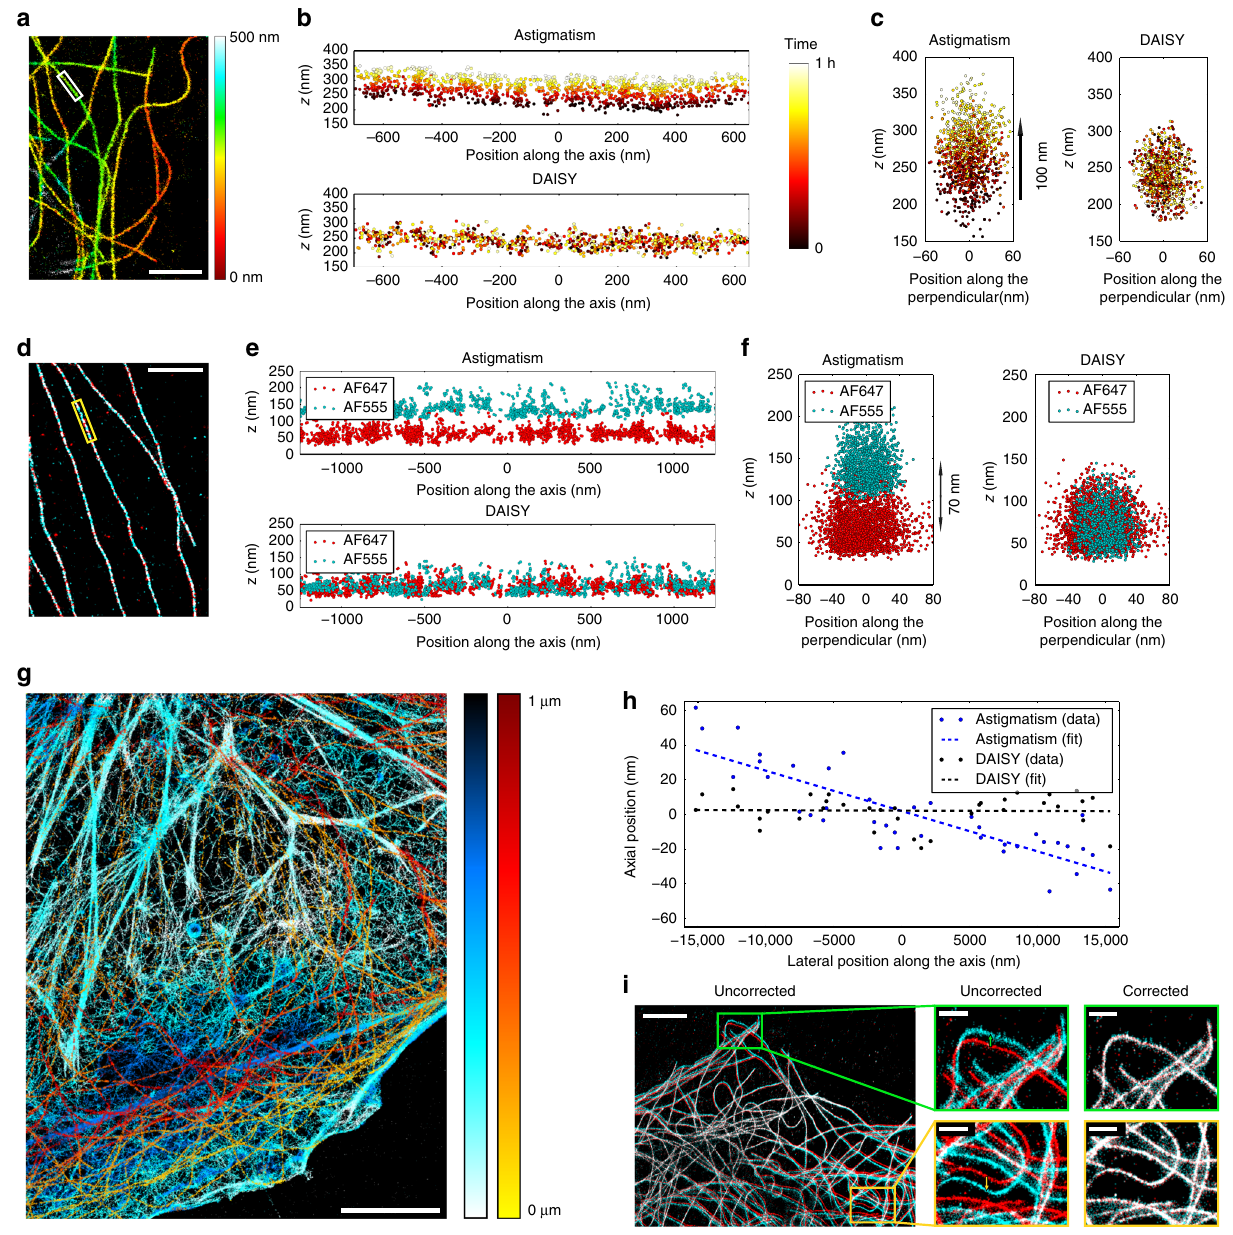
Fig. 2 Characterization of the performance of DAISY. a – c Illustration of the effect of axial drifts. a Depth map of microtubules (COS-7 cells, α -tubulin labeled with AF647). The x – z ( b ) and y – z ( c ) pro fi les of the boxed microtubule are plotted for both standard astigmatic imaging and DAISY. The time is color-coded over 1 h to highlight the effect of the temporal drift. d – f Effect of the chromatic aberration. d 2D localization image of microtubules (COS-7 cells, α -tubulin labeled with AF555 and β -tubulin labeled with AF647) sequentially imaged in two different colors (red: AF647, cyan: AF555). The x – z ( e ) and y – z ( f ) pro fi les of the boxed microtubule are plotted for both standard astigmatic imaging and DAISY. g Dual-color depth map of actin (cyan-blue) and tubulin (yellow-red) in COS-7 cells (actin labeled with AF647-phalloidin and α -tubulin labeled with a 560-nm excitable DNA-PAINT imager). h In fl uence of the sample tilt on the axial detection. The same fi eld of 20-nm dark red fl uorescent beads deposited on a coverslip was imaged with both standard astigmatic imaging and DAISY and the results were averaged over 500 frames to suppress the in fl uence of the localization precision. The detected depth pro fi le is plotted along the tilt axis. i Illustration of the image lateral deformation induced by the astigmatism. For the same acquisition (COS-7 cells, α - tubulin labeled with AF647), 2D images were reconstructed from the lateral positions measured on both the astigmatic UAF (in cyan) and the unastigmatic EPI (in red) detection paths of our setup, before the deformation correction (left) and after (right). The whole fi eld and zooms on the boxed regions are both displayed. Scale bars: 2 μ m ( a ) and ( d ), 5 μ m ( g ) and ( i ) left, 1 μ m ( i ) right